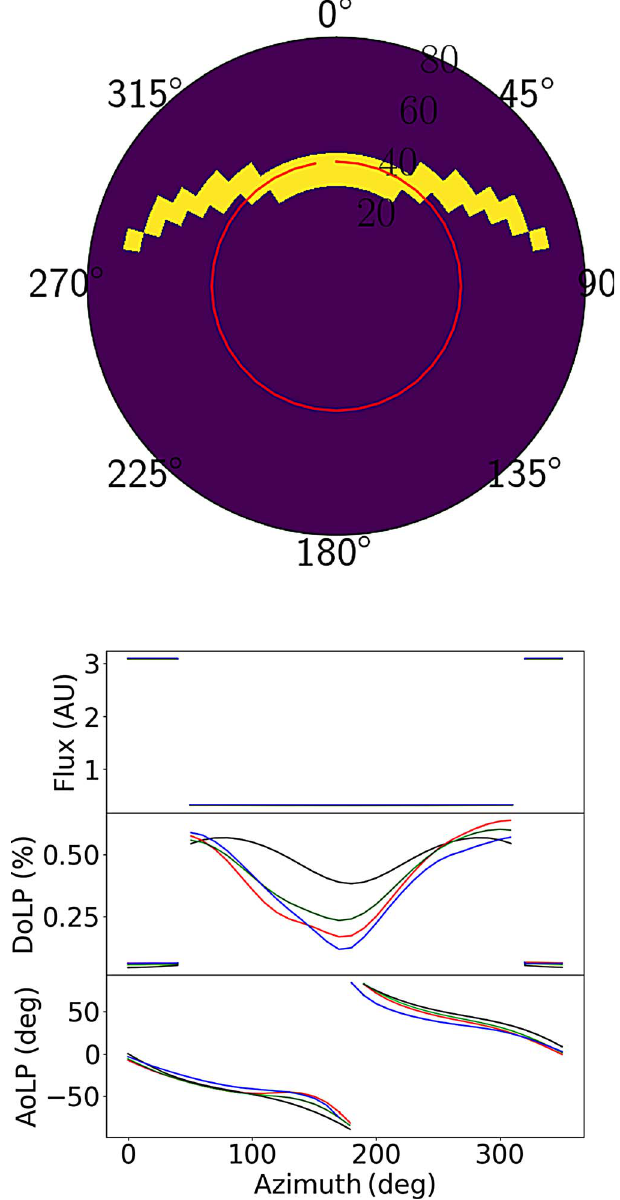
Fig. 4. Top: All-sky image for an East – West synthetic aurora spanning the sky at 45 (cid:3) elevation Northward. The red curve shows the pointing direction of the instrument along a 45 (cid:3) almucantar. The radiance of the aurora (in yellow) is 100 nW/m 2 /sr, against 10 nW/ m 2 /sr for the background. Bottom: Almucantar under a synthetic aurora. Comparison using different albedo curves from Figure 3. In black: no albedo. Other colors match the pro fi les shown in Figure 3. Azimuths are indicated with respect to the Northern direction, positive